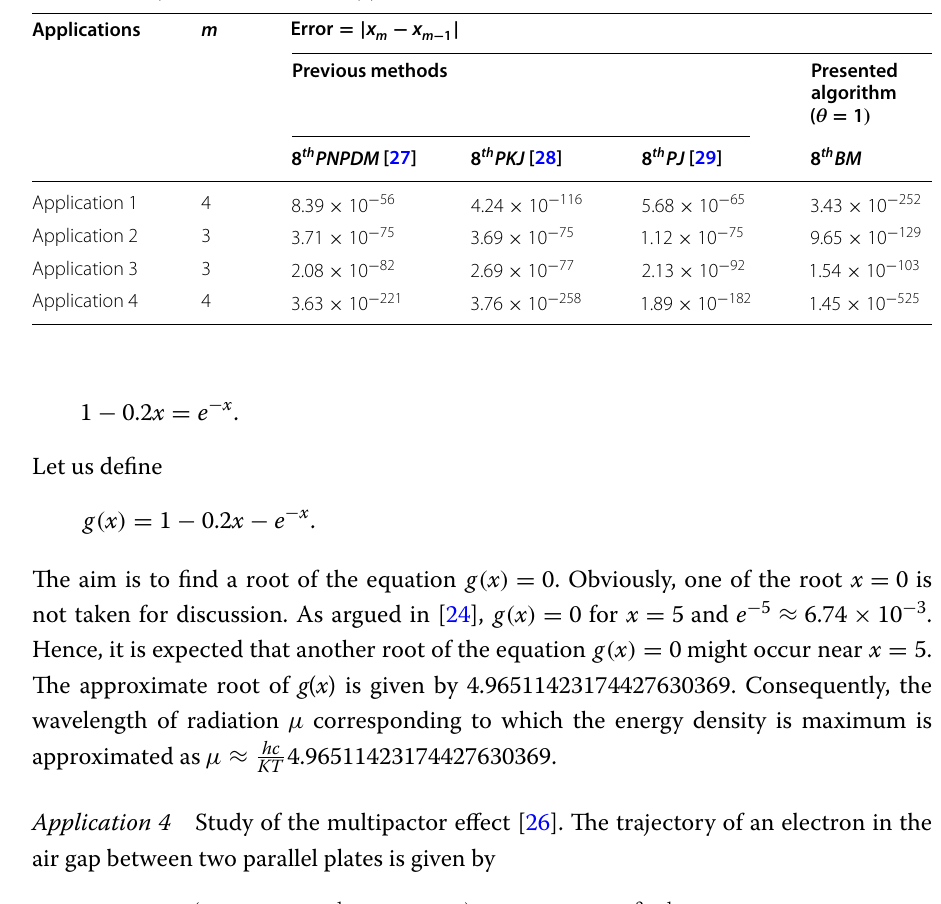
Table 3 Comparison of results for